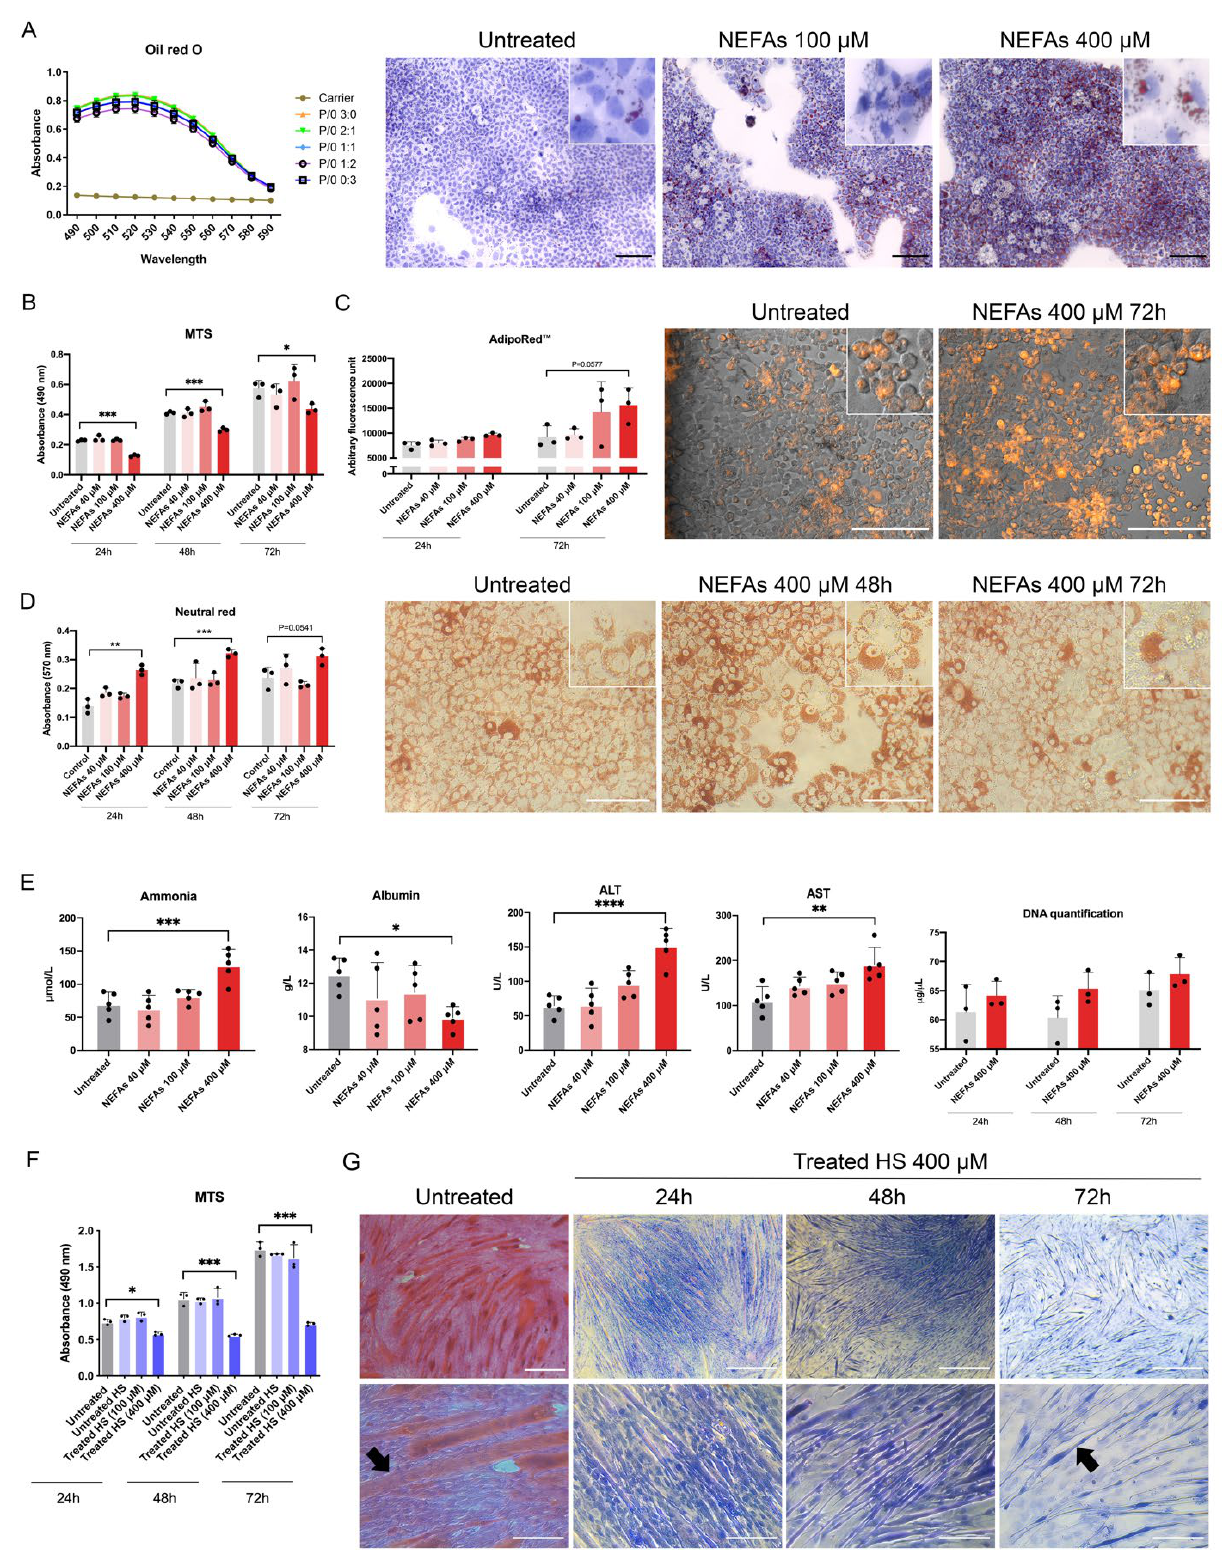
Figure 2. 2D in vitro models of fatty hepatocytes (AML12) and sarcopenic skeletal muscle cells (C2C12). ( A ) Absorbance signal of various internalized non-esterified fatty acids (NEFAs) combina- tions assessed by Oil-red-O assay (P = palmitic acid; O = oleic acid) after 48 h. Scale bar = 500 µm. ( B ) Metabolic activity of AML12 cells challenged with various concentrations of NEFAs measured by MTS assay. ( C ) Intracellular lipid accumulation was assessed quantitatively (fluorimeter) and qualitatively (confocal microscopy) by AdipoRed™ assay. Scale bar = 100 µm. ( D ) AML12 cells’ lysosomal re-arrangement upon NEFAs challenge assessed quantitatively (spectrometer) and